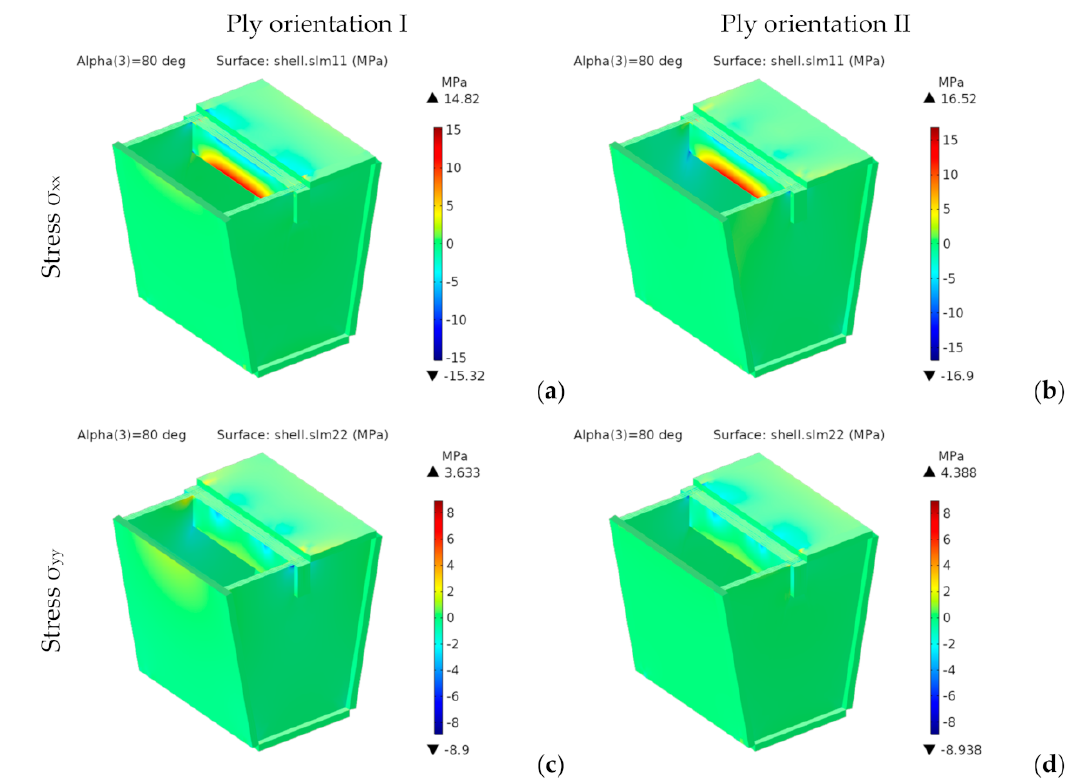
Figure 21. 1st design. Stresses under the seating surface for top discontinuity: ( a , b ) σ xx [MPa], ( c , d ) σ yy